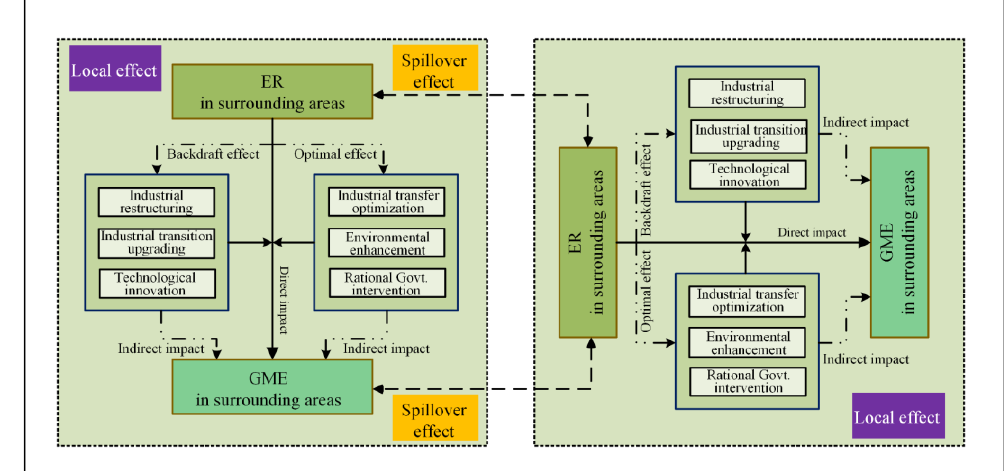
Figure 6. Theoretical Framework.